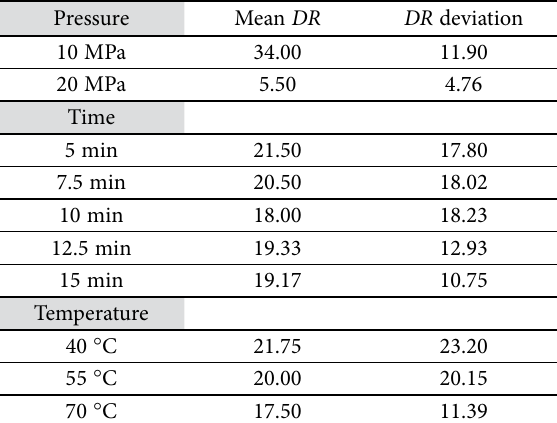
Table 2. Distribution of delamination ratio grouped by lamination pressure, time and temperature